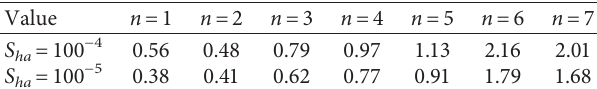
Table 1: Relationship between quality factor and false alarm probability and reference window